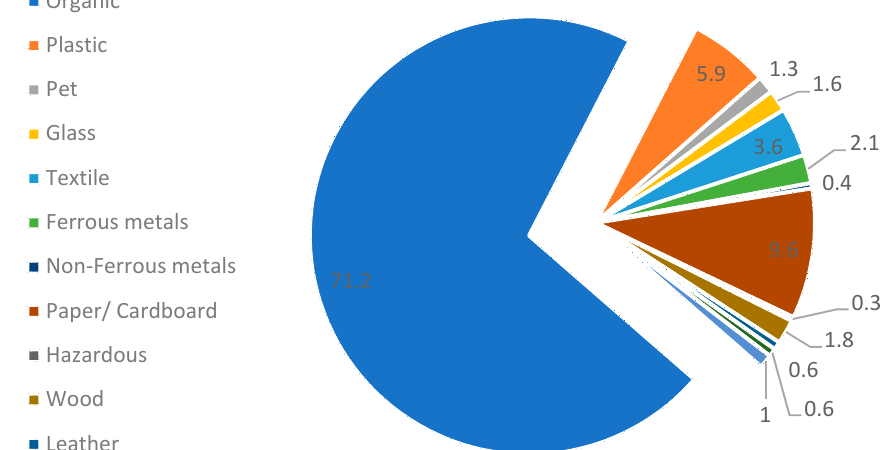
Figure 3. Waste Composition breakdown at Aradkouh-Tehran.